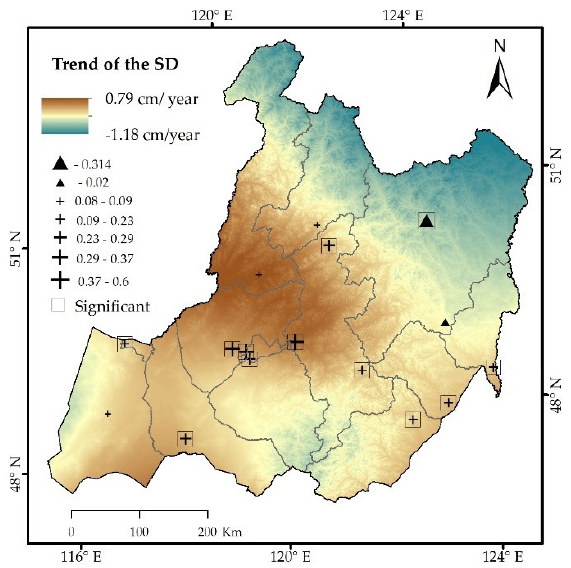
Figure 11. Spatial variation trend in annual snow depth in the Hulunbuir region during the period of 1979–2018 ( + indicates an increasing trend, ▲ indicates a decreasing trend, □ indicates a significant station).